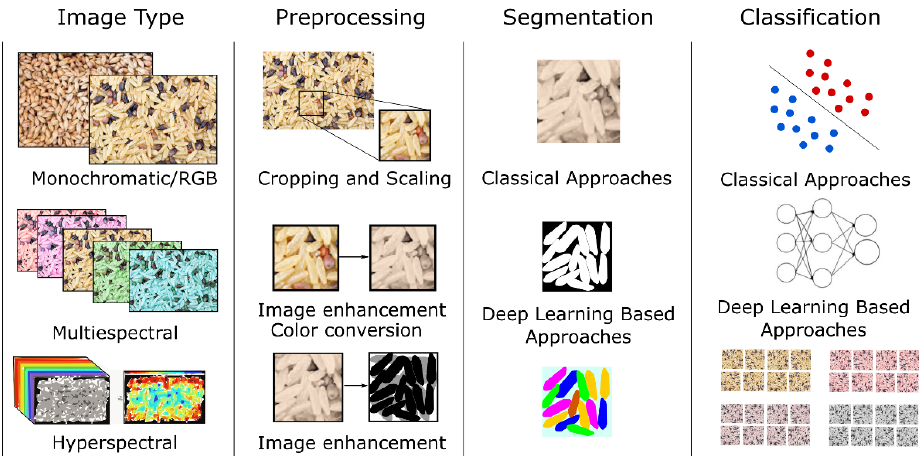
Figure 1. Stages of the analysis of artificial vision in the detection of grain properties.